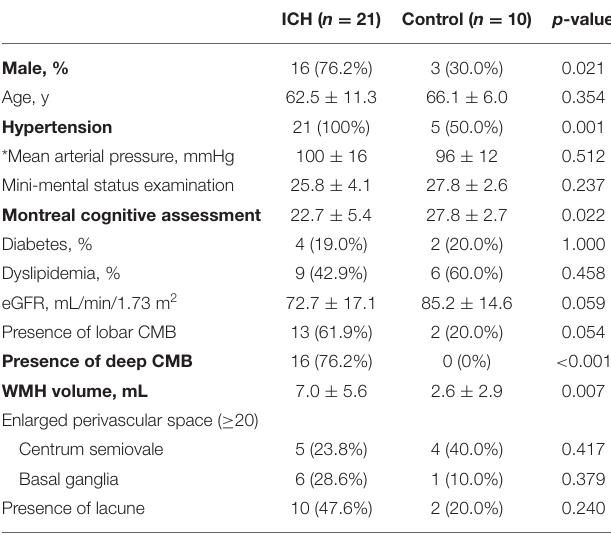
TABLE 1 | Demographics in patients with spontaneous intracerebral hemorrhage and